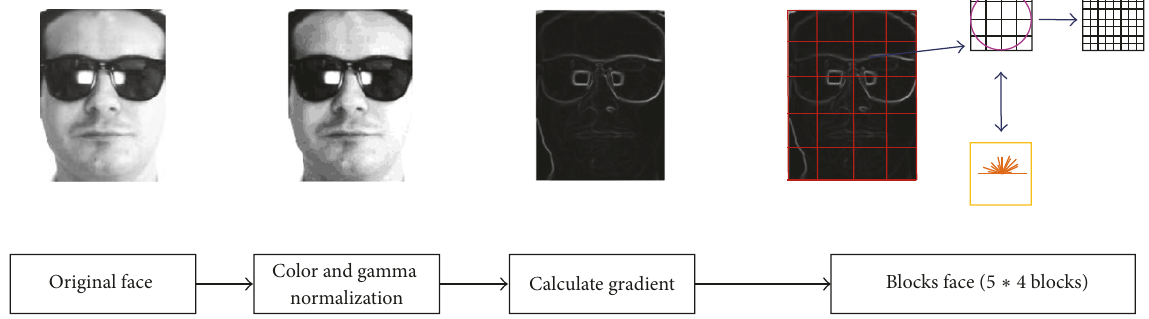
Figure 3: The main process of extracting the HOG features. According to [15, 17], we empirically set these parameters as follows: the block includes 4×4 cells, the size of cell is 8×8 pixels, the gradient orientation is 180 ∘ , and the bins of histogram for 4×4 cells at the corresponding position are 12. And the final descriptor vector is made up of these 12 bins oriented gradient histograms.